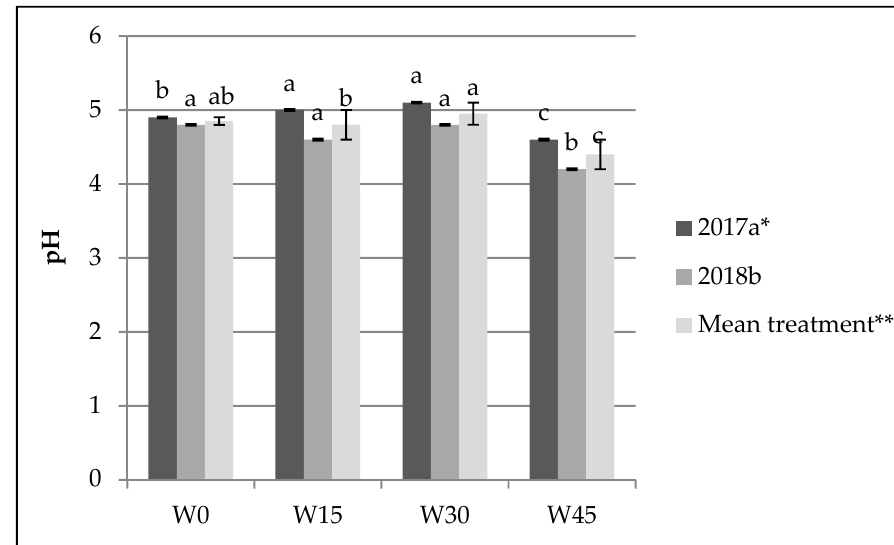
Figure 12. Soil pH. W0—the control with no stillage treatment, W15—15 m 3 of stillage per hectare, W30—30 m 3 of stillage per hectare, W45—45 m 3 of stillage per hectare. * means of years regardless of treatments; ** means of treatments regardless of years. The same letter means not significantly di ff